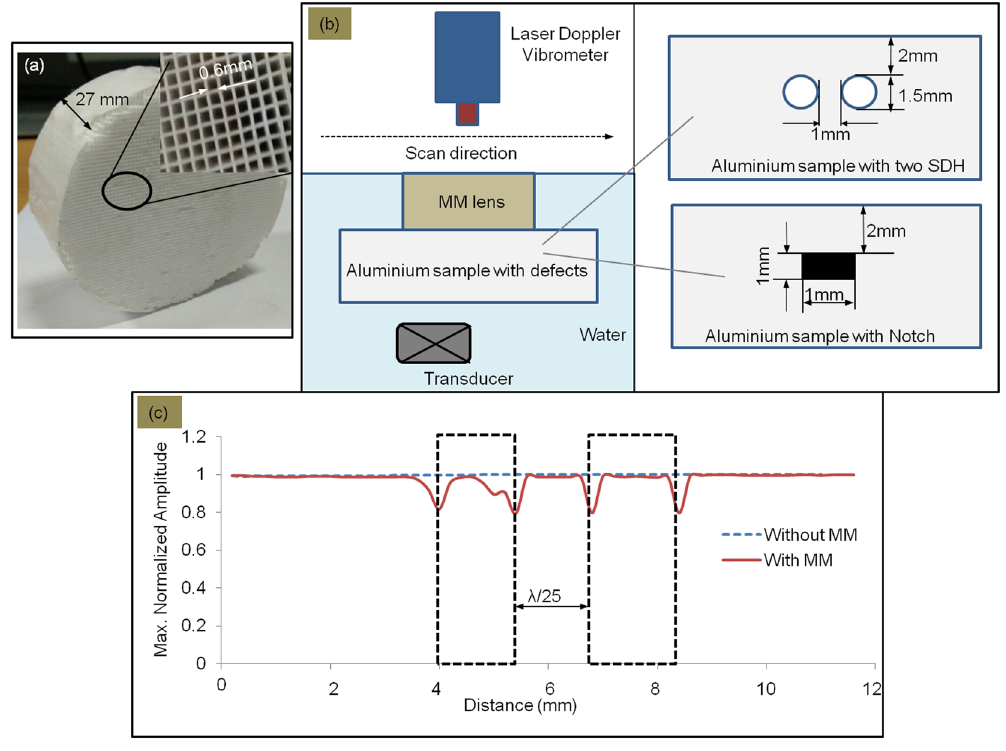
Figure 2. ( a ) Photograph of the holey structured metamaterial lens made with optimal parameters; ( b ) Illustration of experimental set-up (In-set details of two types of defects considered in an aluminium sample); ( c ) Experimental results for maximum normalized amplitude variation with the monitored positions across the sample: the two dotted rectangular boxes indicate actual positions of the defects in the aluminium